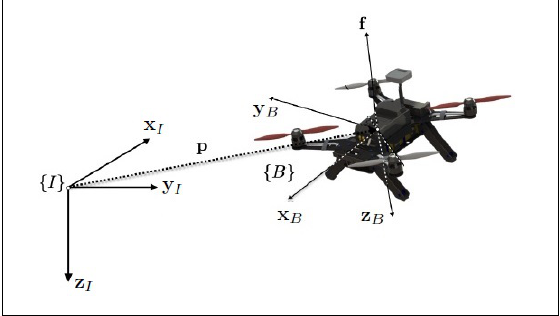
Figure 1. The quadrotor reference